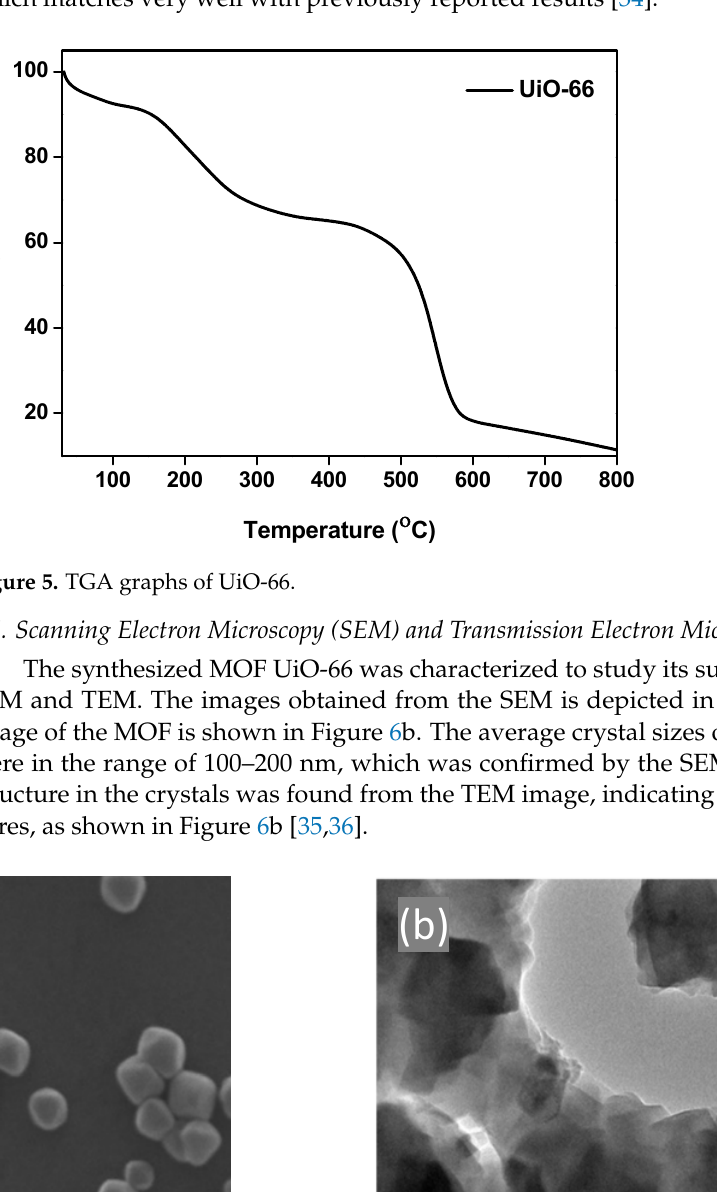
Figure 4. N 2 adsorption isotherm graphs of UiO ‐ 66.